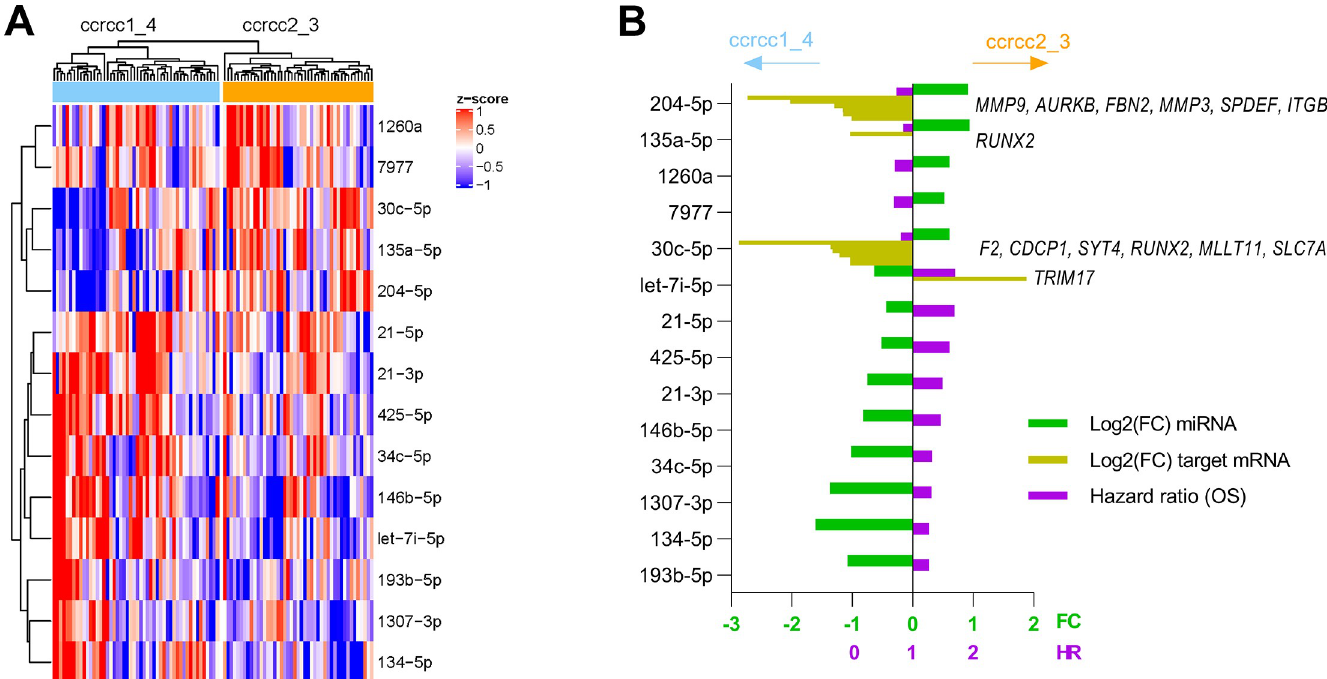
Fig 3. Summary of selected miRNAs with the highest discriminatory power for both molecular subtype and OS (Leuven dataset, n = 95). All miRNAs that were associated with poor prognostic ccrcc1_4 subtypes were systematically associated with poor OS, and vice versa . (A) Heatmap. (B) Bar plots quantifying subtype-specific miRNA expression, hazard ratio for OS and subtype-specific mRNA expression of predicted mRNA targets that were downregulated with a fold change � 0.5 compared to the other subtype. All results are significant after correction for multiple testing (FDR < 0.05). FC = fold change; OS = overall survival.